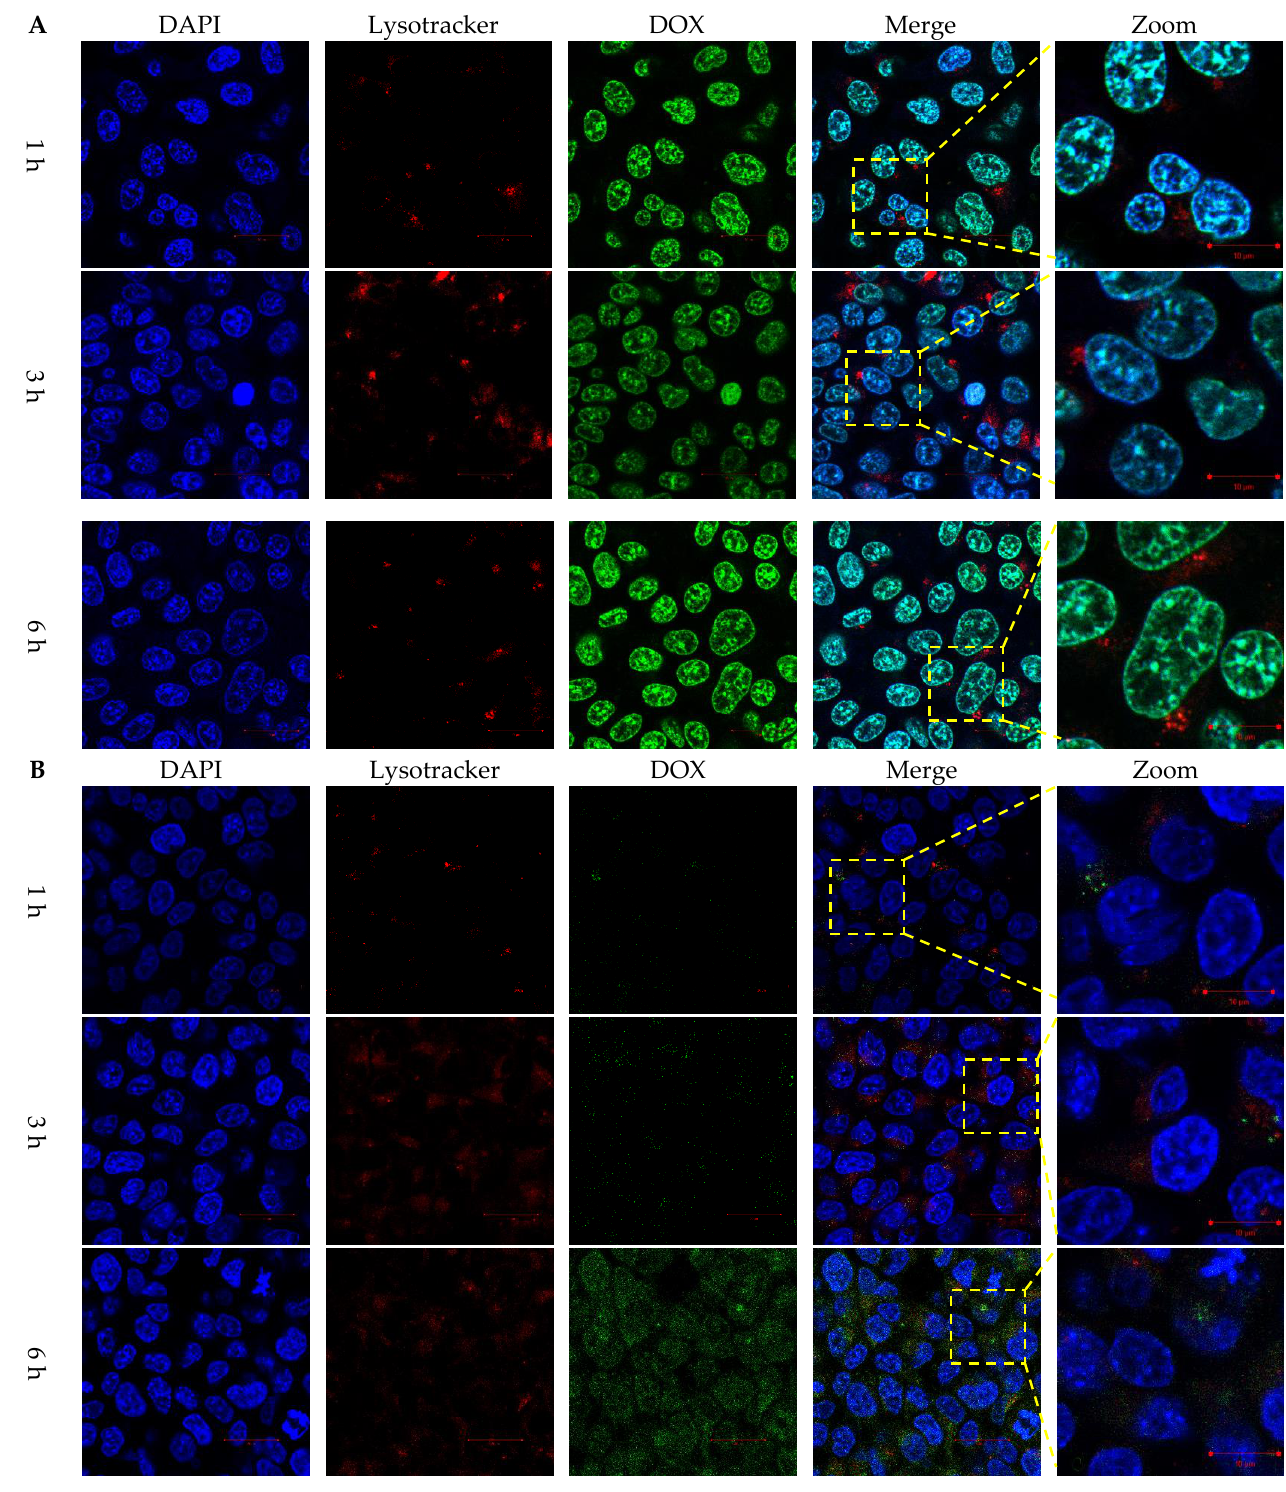
Figure 5. Intracellular DOX release behaviors of lipopolyplexes. Confocal images of HCT116 cancer cells treated with ( A ) free DOX and ( B ) DLP for 1, 3 and 6 h. The blue, red and green colors represented DAPI-stained nuclei, lysotracker stained lysosome, and DOX, respectively. The scale bars were 20 µm.